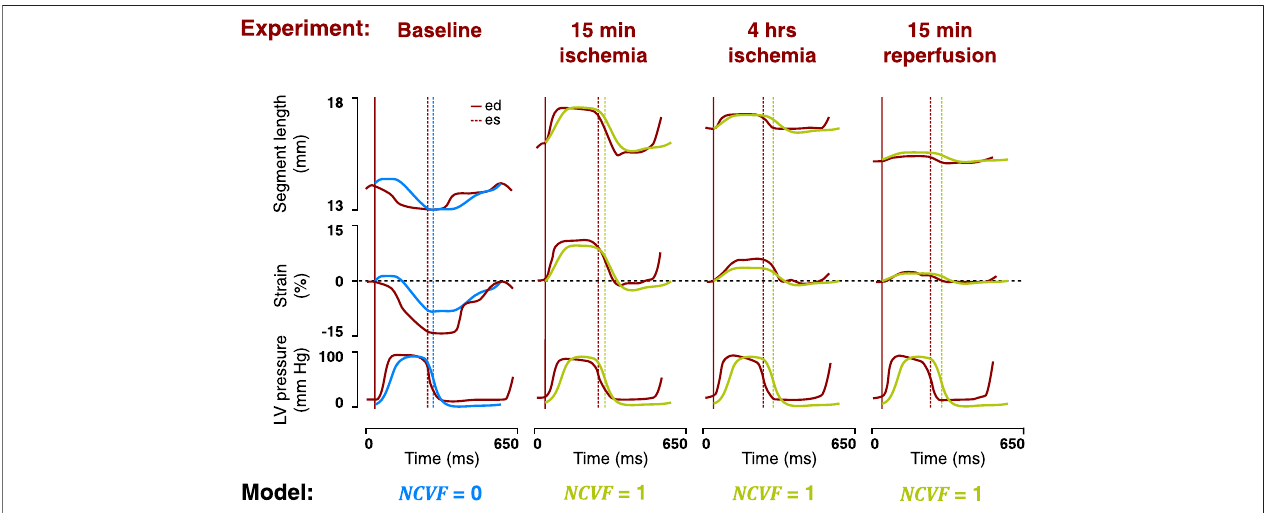
FIGURE 7 | Comparison between the temporal behavior of the measured segment length, strain, and LV pressure in the same representative dog as in Figure 6 after 15 min and 4 h of left anterior descending (LAD) coronary artery occlusion, followed by 15 min of reperfusion (dark red tracings, resketched from Lyseggen et al. (2005)) and the simulated segment length, strain, and LV pressure (blue and green tracings) for no contractile dysfunction ( NCVF = 0) and for three simulations of completecontractiledysfunction( NCVF =1),withcalibratedvaluesofthenonlinearityparameter( k ECM )andzero-stresssarcomerelength( L s 0 , pas ).ed,end-diastole; es, end-systole.